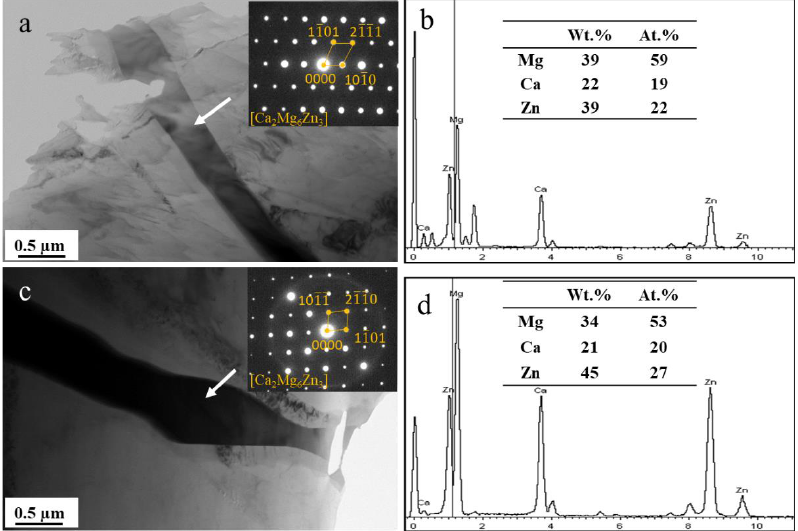
Figure 3. TEM images and EDS results of the secondary phases: ( a , b ) ZM-0.3Ca and ( c , d ) ZM-0.5Ca alloys.